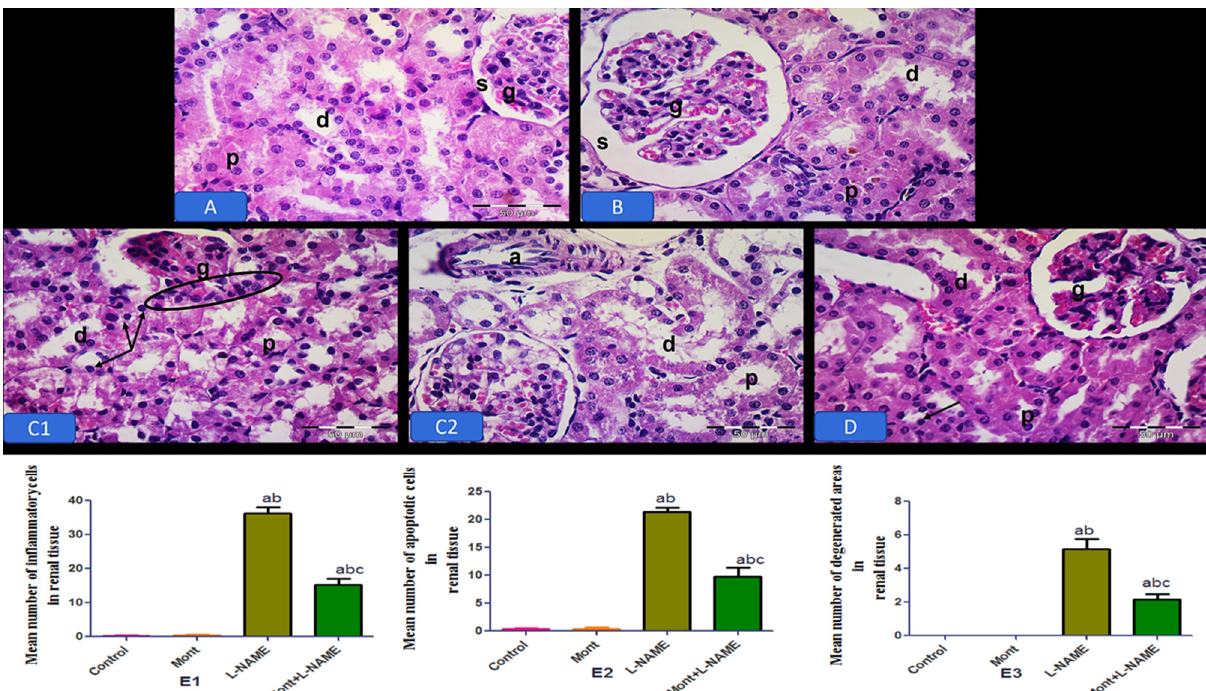
Figure 8. Effect of montelukast on kidneys in a pre-eclampsia model in rats. Photomicrographs of the renal cortex of the control ( A ) and the Mont ( B ) groups displaying normal organization of the renal cortex. Notice the glomerular capillary tufts (g) and Bowman’s space (s). PCTs (p) have a narrow lumen and a highly acidophilic cytoplasm. DCTs (d) have a wider lumen and less acidophilic cytoplasm with vesicular nuclei (arrow). ( C1 , C2 ) The L-NAME group showing disturbed lobular architecture with dilated interlobular arteries (a). Notice the atrophic glomerulus (g), dilated PCTs (p), DCTs (d), and the numerous apoptotic cells (arrows) lining the tubules. Inflammatory cell infiltration is also detected (circle). ( D ) The Mont + L-NAME group showing the restoration of normal architecture. The renal tissue approaches the normal structure. H&E × 400. ( E1 – E3 ) The histopathological changes in renal tissue in all groups. The data are mean ± SEM (8 rats/group). (a) Significant ( p < 0.05) difference from the control group. (b) Significant ( p < 0.05) difference from the Mont group. (c) Significant ( p < 0.05) difference from the L-NAME group. [Mont: montelukast;